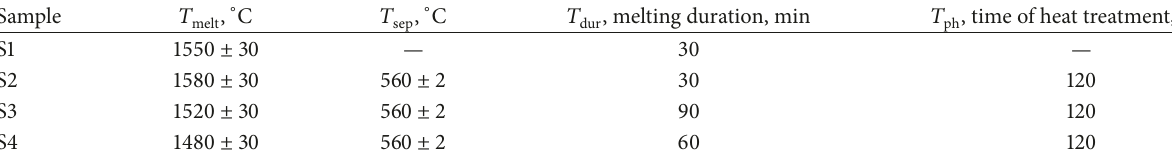
Table 1: Melting and phase separation parameters.